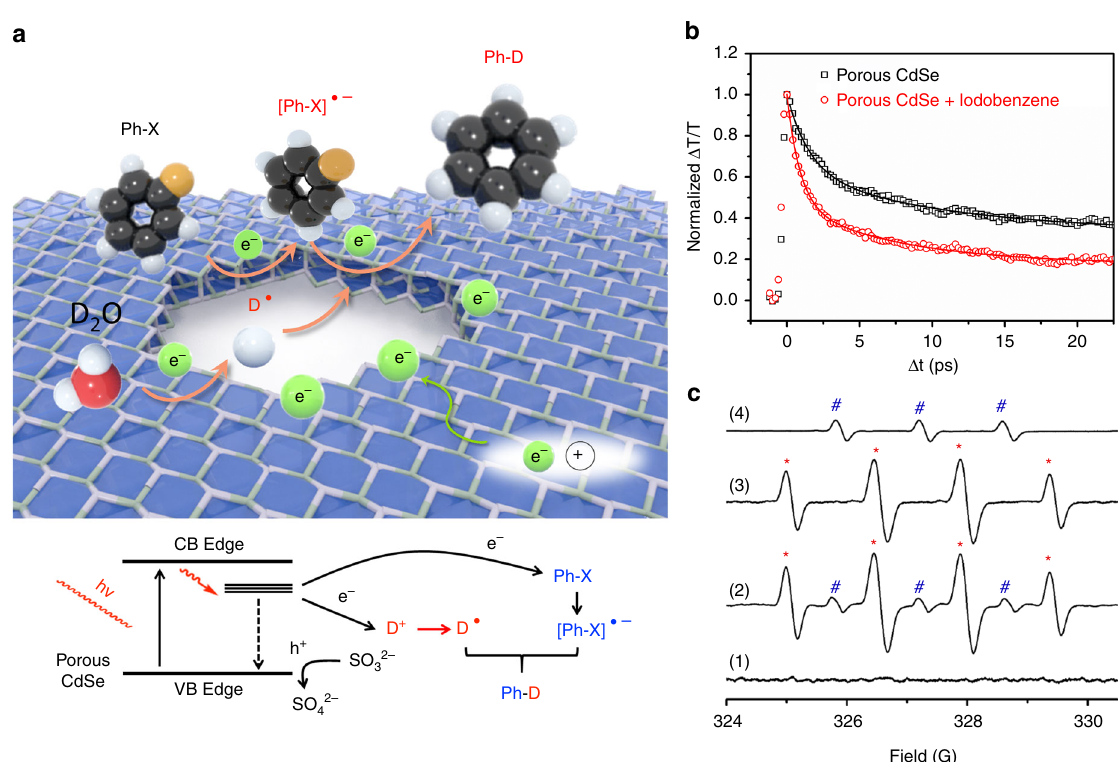
Fig. 4 Mechanism of the photocatalytic deuteration reaction. a possible radical pathway for C – X to C – D transformation; b comparison of femtosecond transient absorption kinetics of porous CdSe with/without the addition of iodobenzene in CHCl 3 . Pump: 400 nm, probe: 450 nm; c EPR measurements of 1 mM CdSe nanosheets with 4 mM DMPO and 0.13 M Na 2 SO 3 in (1:1 v/v) CH 3 CN/H 2 O under UV ( > 280 nm) irradiation: (1) with 2 mM p -iodoanisole in the dark, (2) with 2 mM p -iodoanisole after 30 s irradiation, (3) without p -iodoanisole after 35 min irradiation, and (4) only with 1 mM CdSe and 4 mM DMPO in iodobenzene after 150 s irradiation; * and # represent peaks from DMPO-OH and DMPO-C